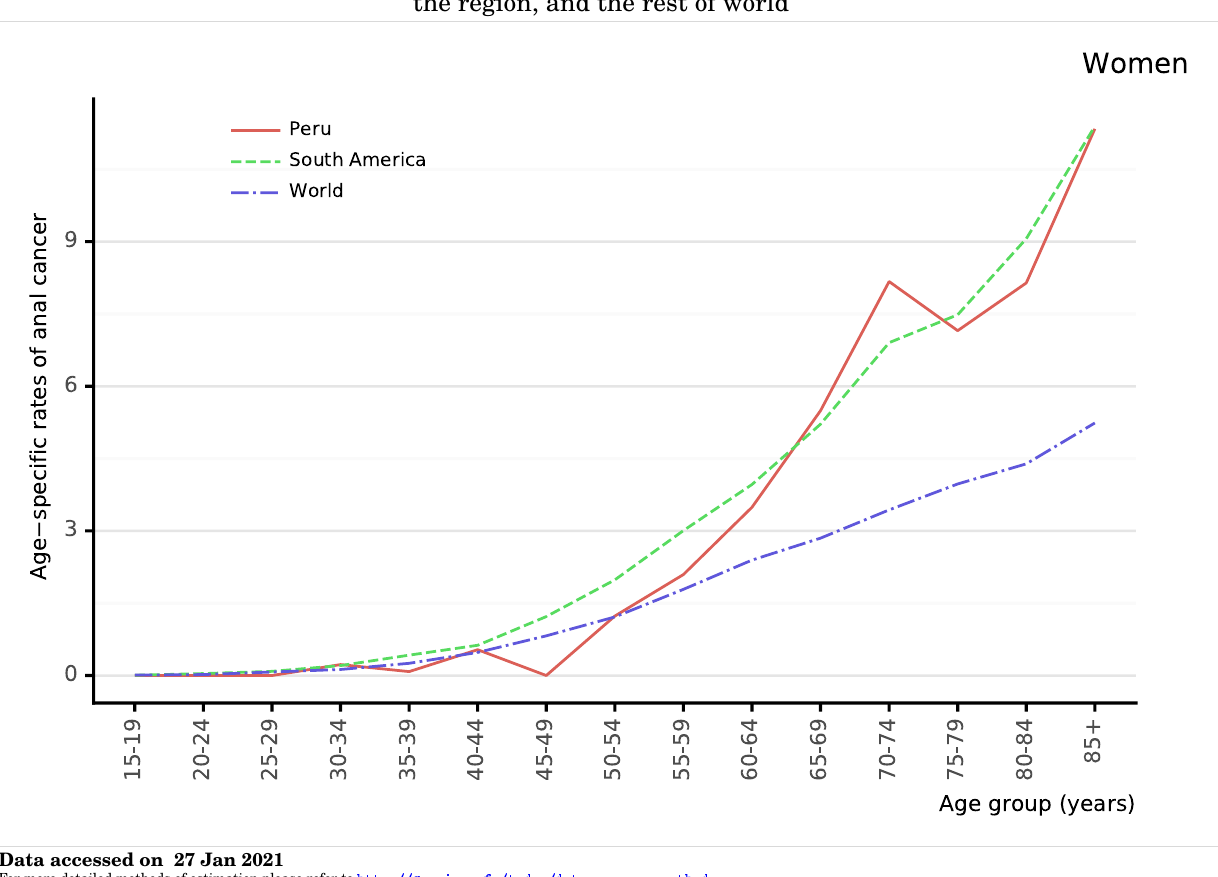
Figure 80: Comparison of age-specific anal cancer incidence rates among women by age in Peru, within the region, and the rest of